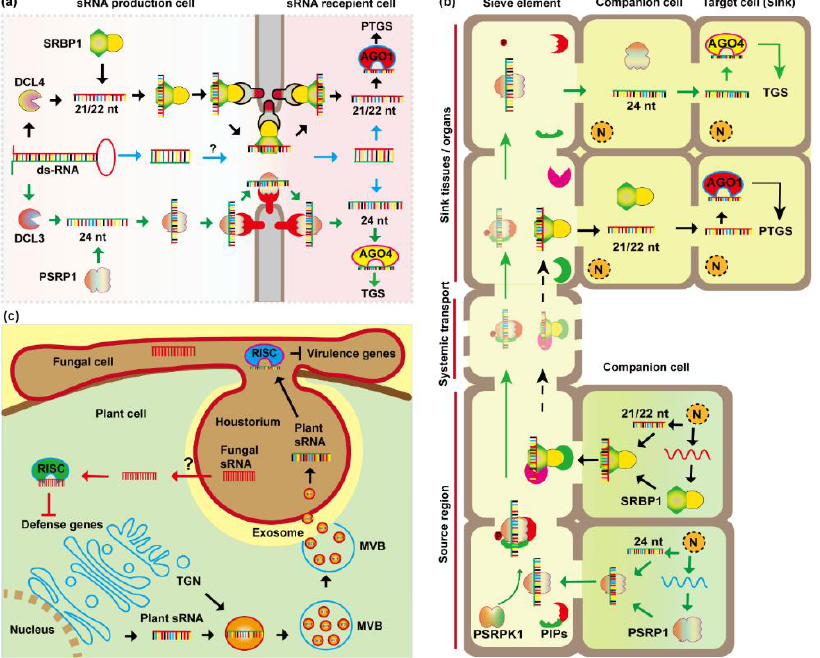
Figure 3. Molecular mechanism of sRNA movement. ( a ), The small-RNA binding proteins SRBP1 and PSRP1 mediate sRNA cell-to-cell movement through PD. SRBP1 binds 21/22 nt sRNA to mediate sRNAs cell-to-cell movement in SRBP1-sRNA ribonucleoprotein (RNP) form, to regulate post-transcriptional gene silencing (PTGS) through AGO1 (Black arrows). The 24 nt sRNAs bound by PSRP1 and achieve the cell-to-cell movement in RNP form to function in transcriptional gene silencing (TGS) through AGO4 (Green arrows). Another possible way is that sRNA precursors or ds-sRNA might also be able to travel intercellularly (Blue arrows). ( b ), Schematic illustrating the PSRP1/SRBP1 mediated long-distance transport of si/miRNAs. PSRP1 binds 24-nt si/miRNA in companion cells (CCs) and mediates their movement into the sieve element (SE). In the SE, CmPSRPK1 phosphorylates PSRP1, which stabilizes the PSRP1-sRNA RNP complex for long-distance transportation from source to sink tissues. In a similar approach, the 21/22 nt si/miRNAs are recognized by SRBP1 to achieve the long-distance transport to recipient tissues, to function in PTGS through AGO1. N: nucleus. ( c ), Schematic illustrating cross-species sRNA movement mediated by extracellular vesicles (EV). Fungal sRNAs travel to host cells, through yet uncharacterized mechanism(s), and hijack host RNAi-induced silencing complexes (RISC) to suppress host defense genes (Red arrows). On the other hand, plant cells send effective siRNAs into the fungal cell, through EVs, to silence fungal virulence genes (Black arrows). TGN: trans-Golgi